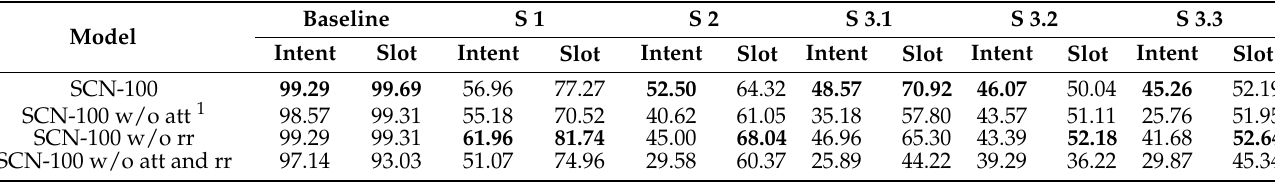
Table 6. Ablation study